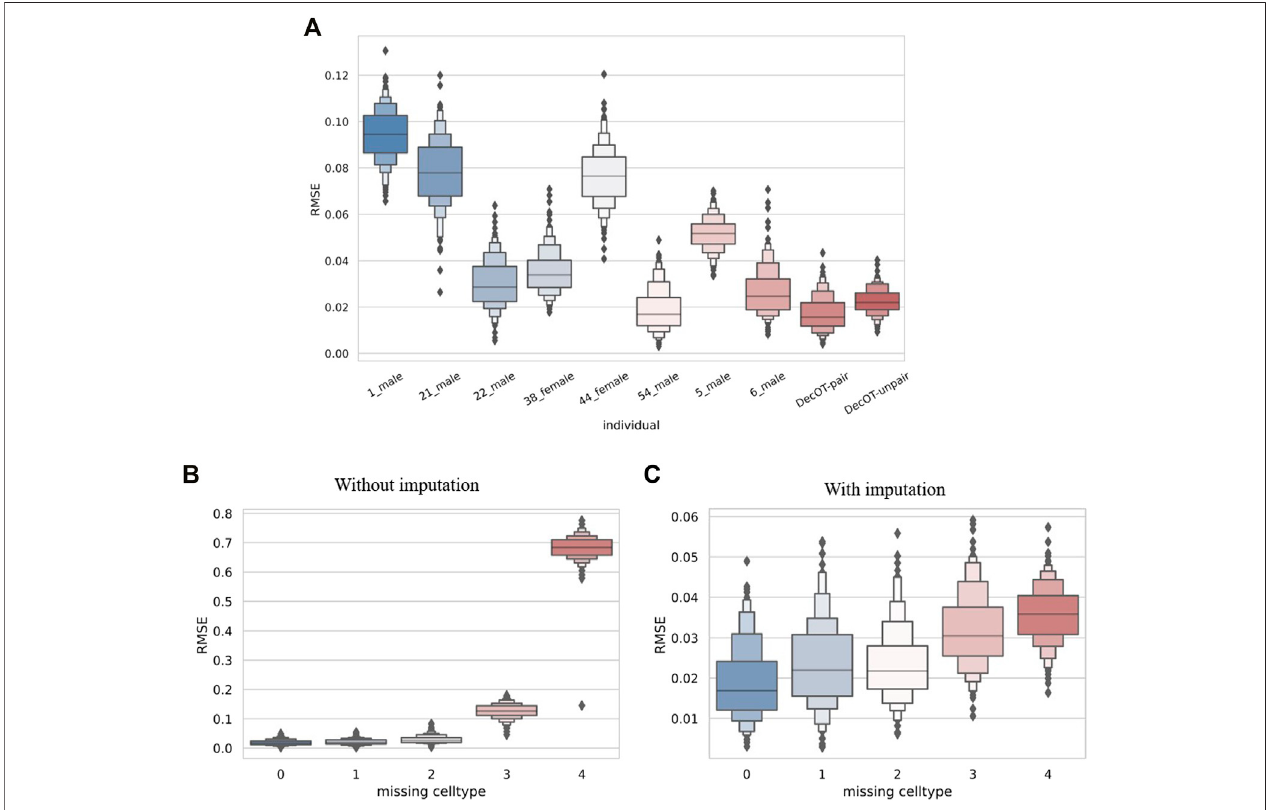
FIGURE3| Effectsunderdifferentmanipulationreferencesbenchmarkedbymixturesconstructedfrom54_maleofGSE81547. (A) Comparisonoftheresultsfrom single individual references and multi-individual references under the ensemble framework. (B,C) Deconvolution results with missing cell types in paired references. The cell types are progressively removed according to the ascending order of cell counts in 54_male. (B) Direct application of the paired reference from 54_male with the missing cell type. (C) Application of the paired reference from 54_male with missing cell types imputed by references from other individuals.